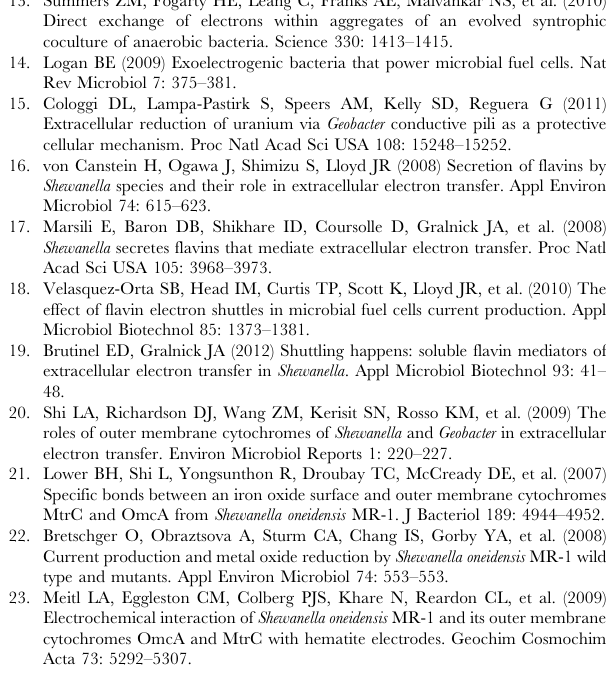
Figure S1 Cell growth during HFO reduction by S oneidensis MR-1 at different DMSO concentrations. Figure S2 The coordination structures of FeO(OH) with three ligands of H 2 O (a) and DMSO (b). Carbon atoms colored in gray, hydrogen white, oxygen red, sulfur yellow, and iron purple. Figure S3 Reduction of DMSO and production of DMS by S. oneidensis MR-1 strains. DMSO was dosed at 2 mM for reduction. Samples at indicated time points from liquid and gaseous phases were collected for DMSO and DMS analysis respectively. DMS concentration was measured using a gas chromatographysystem (GC7890A, Agilent Co., USA) with a flame ionization detector. Gas was sampled from headspace of serum bottles with a syringe and directly injected into gas chromatography for analysis. A commercial GC capillary column